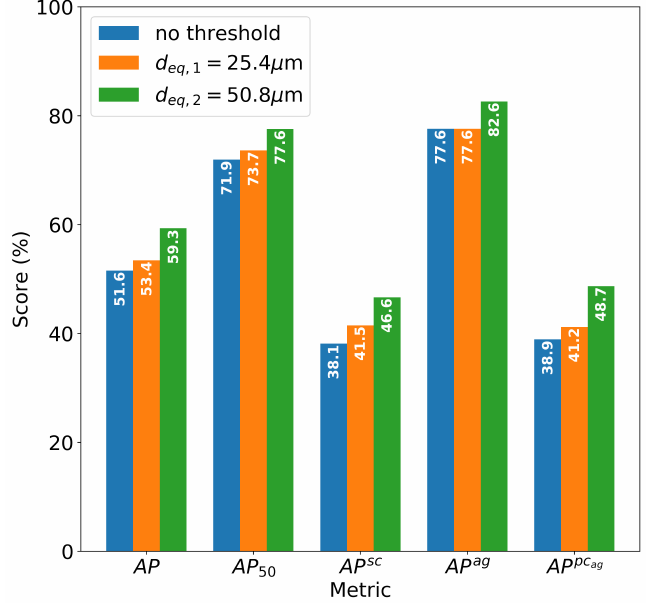
Figure 6. Comparison of different size thresholds for Mask-RCNN